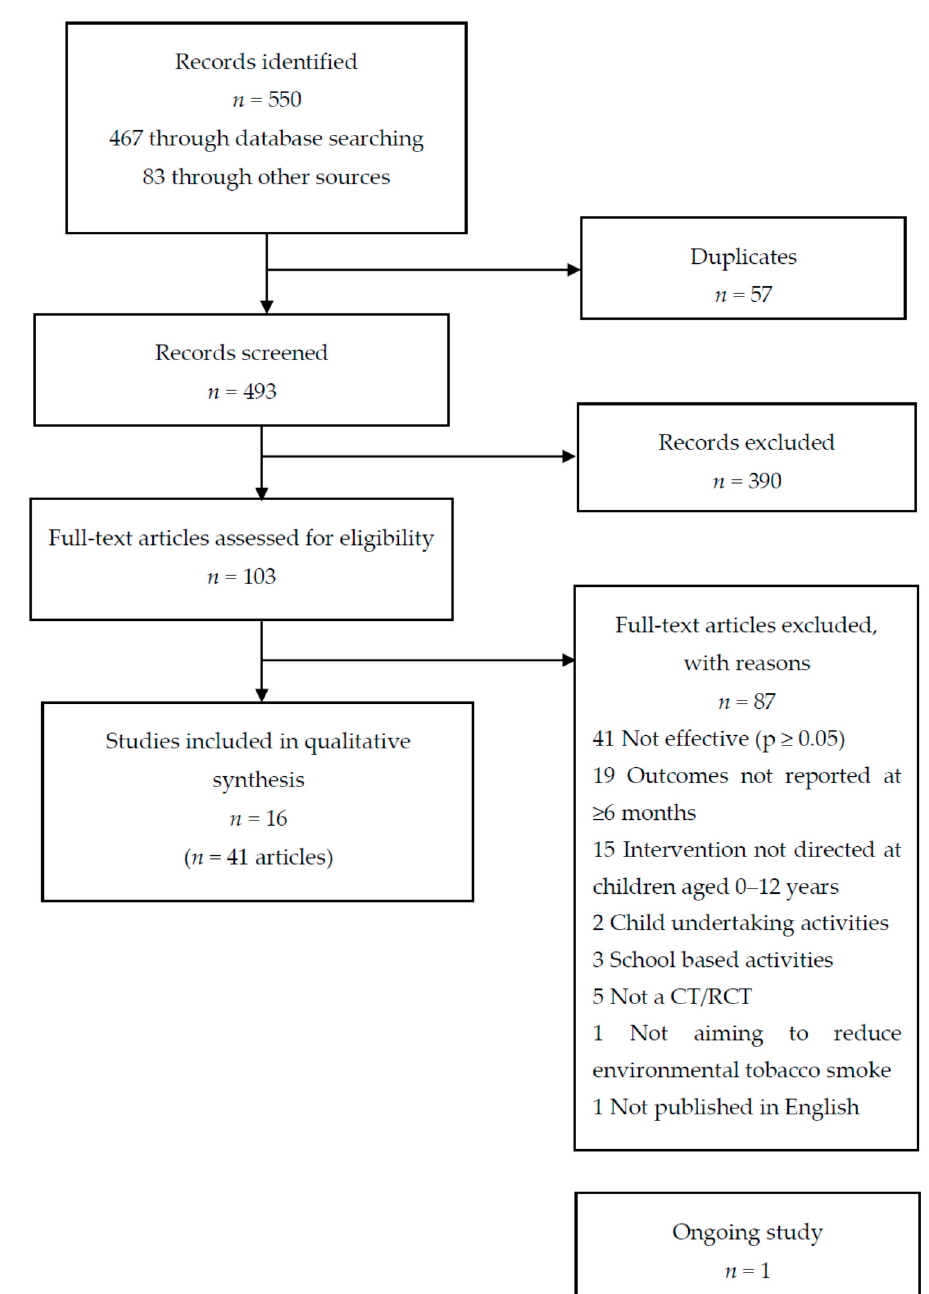
Figure 1. Flow diagram.